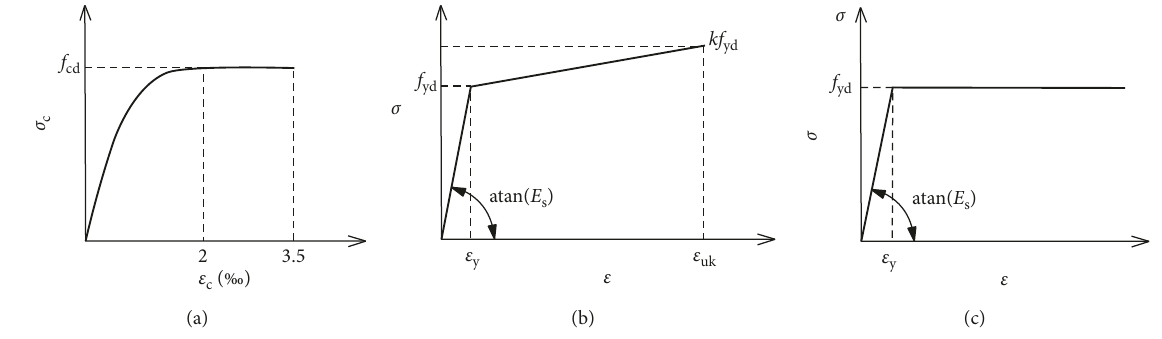
Figure 9: Constitutive relations for (a) concrete, (b) reinforcement, and (c) steel.